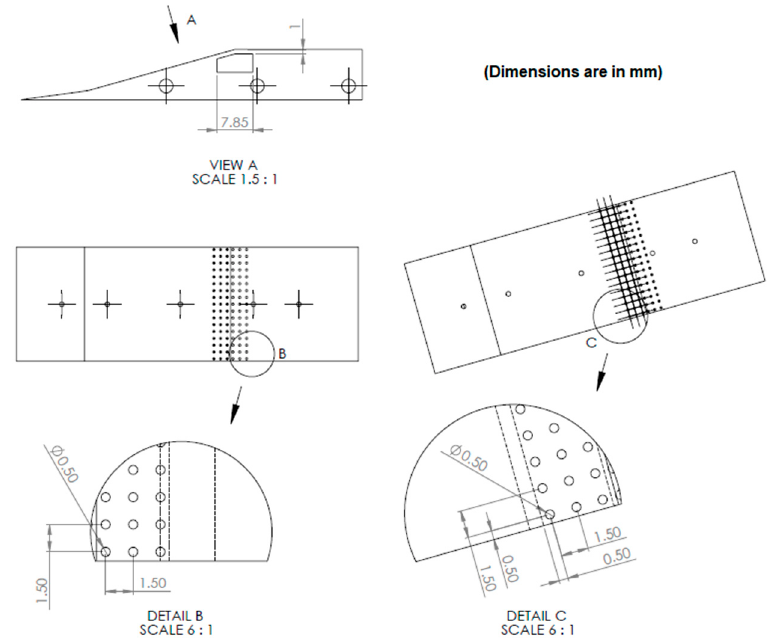
Photographic views of the intake-cores controlled by wall ventilation. Processes 2020 , 8 , x FOR PEER REVIEW